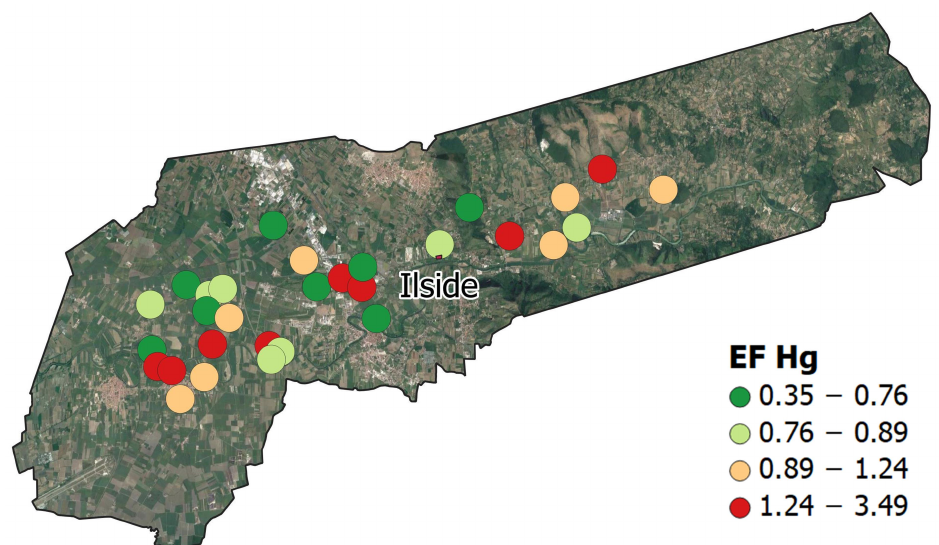
Figure 4. Figure 4. Ilside site. Dot maps of the Hg EFs distribution.